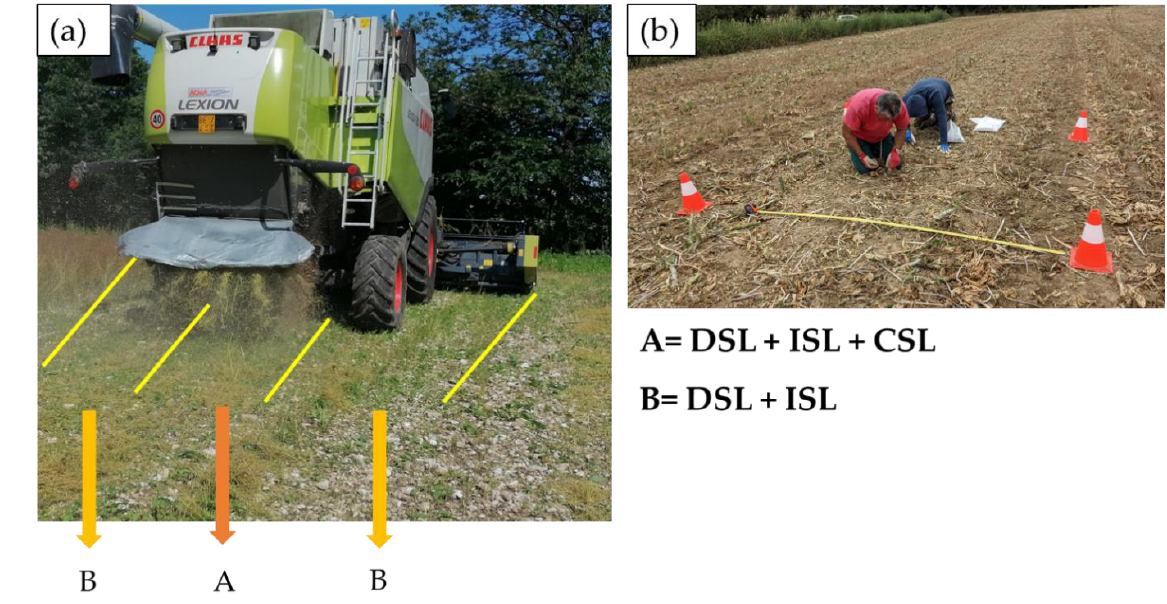
Figure 3. ( a ) Identification of the different zones behind the machinery, image from Stefanoni et al. [25]. ( b ) Sample plot to determine ISL and CSL.